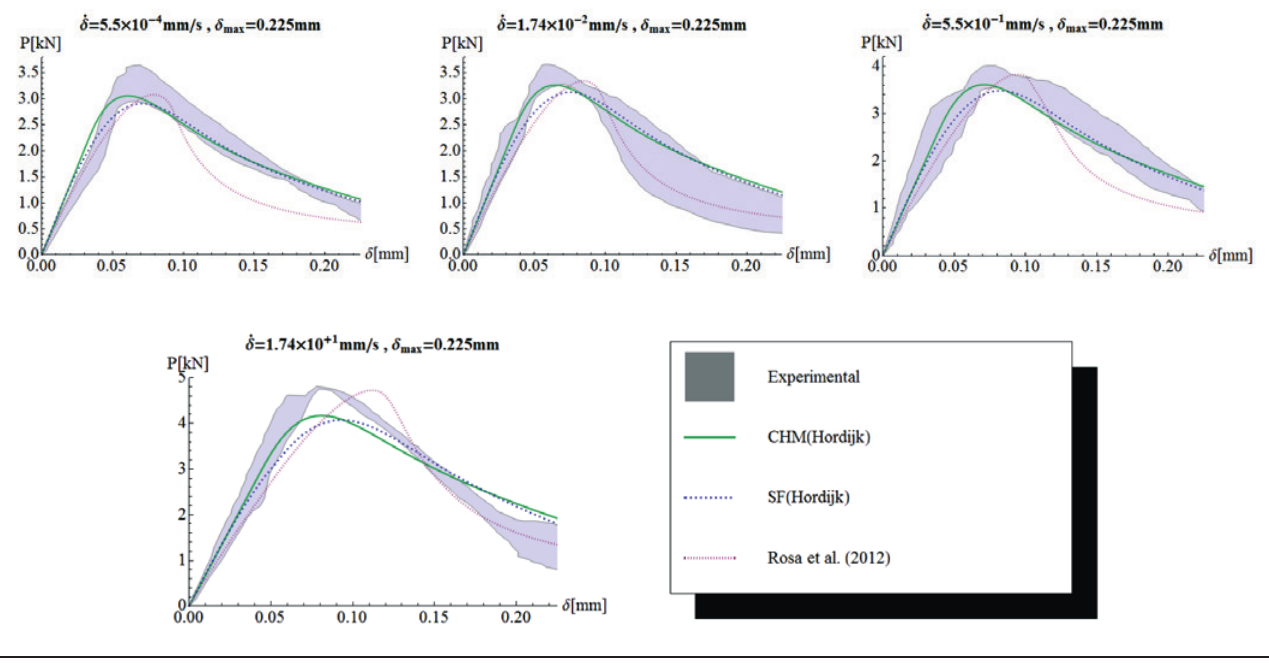
curve for the range of 0 to 0.225mm using Hordijk (1991) [33] curve set in section 5.3P- d